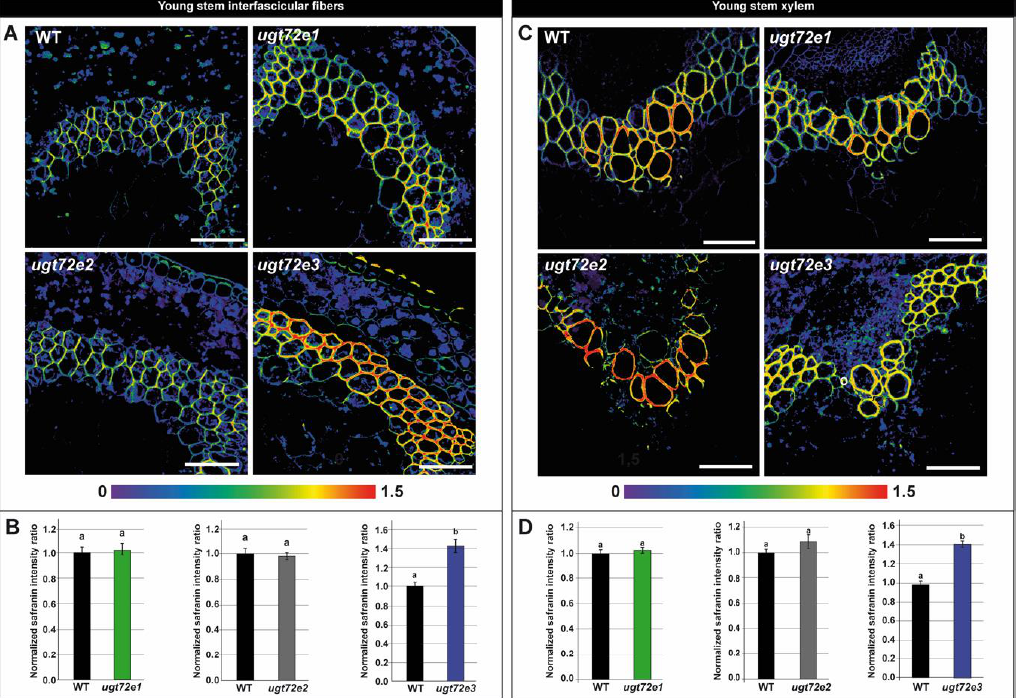
Figure 4. Local lignin content determination on the young parts of the floral stems using safranin O fluorescence-based method on WT and ugt72e mutants. The safranin O ratiometric images are shown in ( A ) and ( C ). The colour range used for image representation varies from the non-normalized ratio 0 (purple) to non-normalized ratio 1.5 (red). Scale bar = 50 µm. Quantification was performed on interfascicular fibers ( B ) and xylem ( D ). The normalized safranin intensity ratios (± SD) are represented. Means (± SD) with the same lowercase letters are not significantly different according to Student t-test ( p -value < 0.01, n = 3).